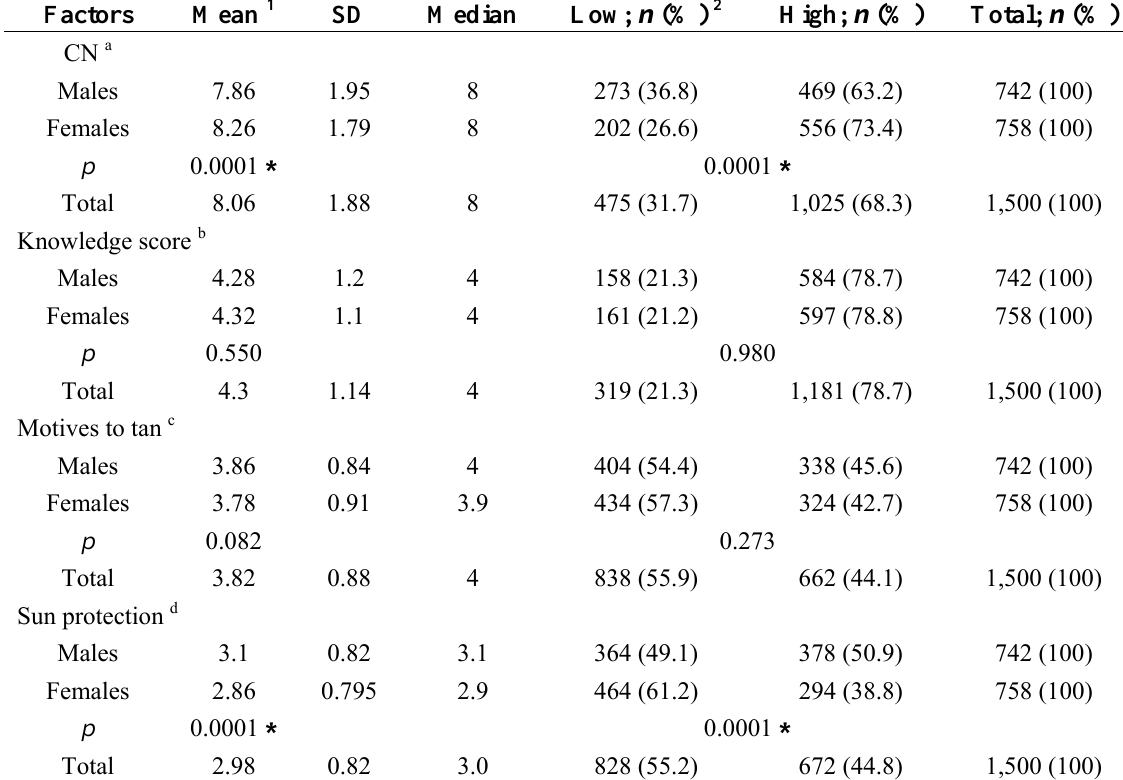
Table 3. Gender differences regarding factor specifications of connectedness to nature (low/high CN), knowledge score, motives to tan, and sun